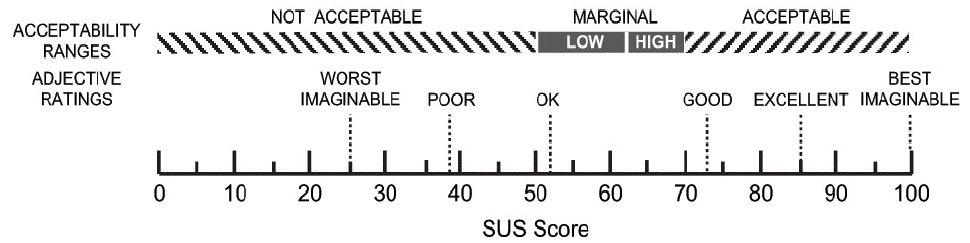
Figure 10. Calibrated scale for interpreting the total score of the system usability scale (SUS) ques- tionnaire [21].